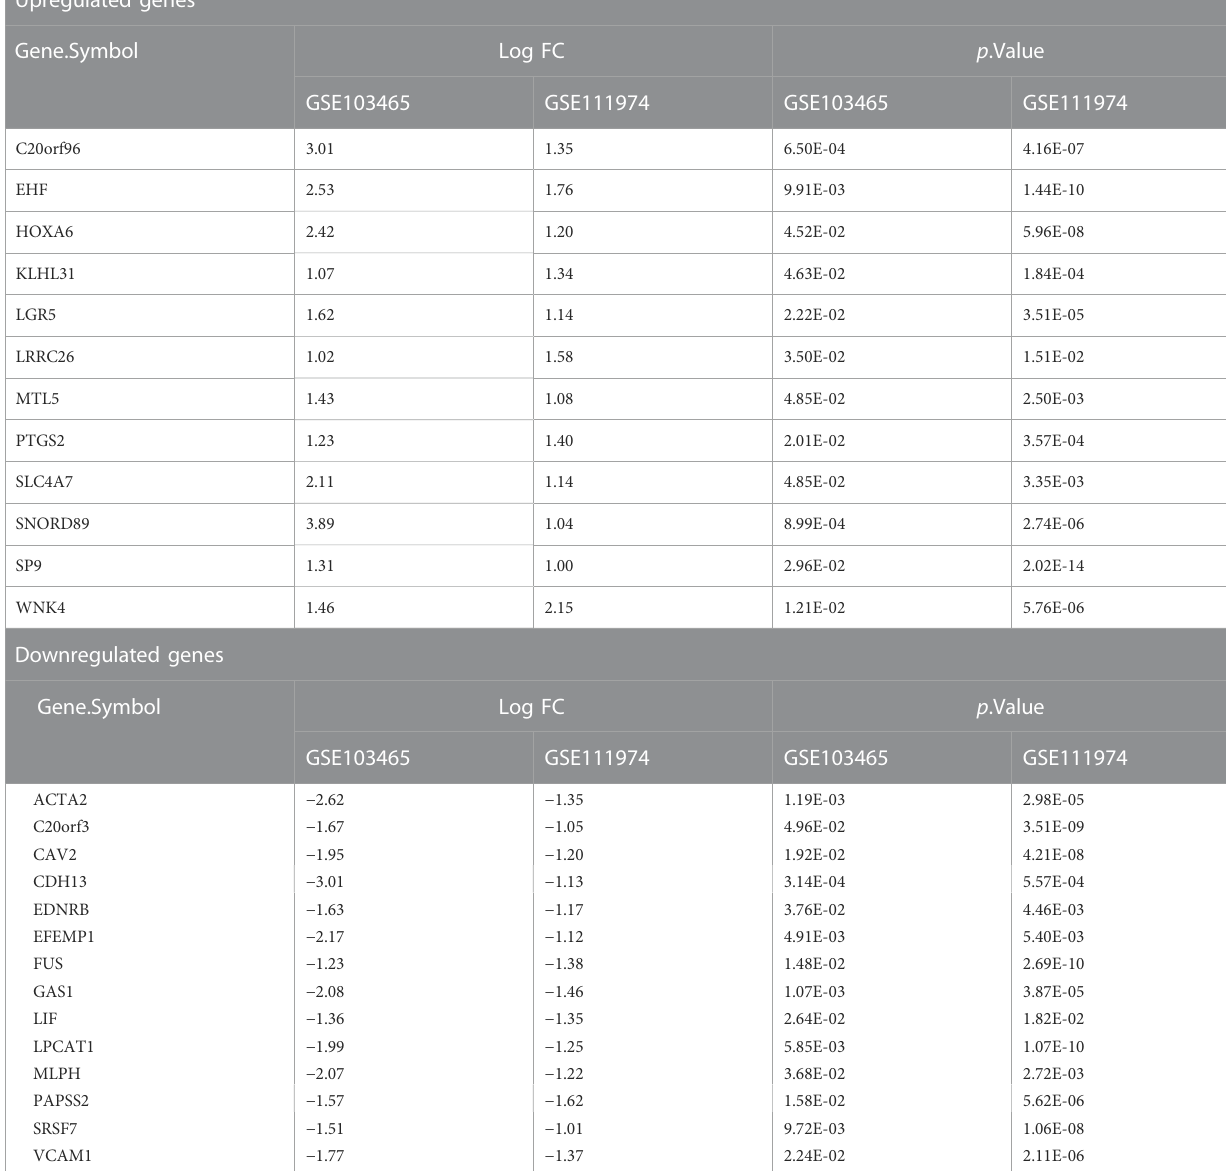
TABLE 2 Log FC and p -value of common DEGs. Upregulated